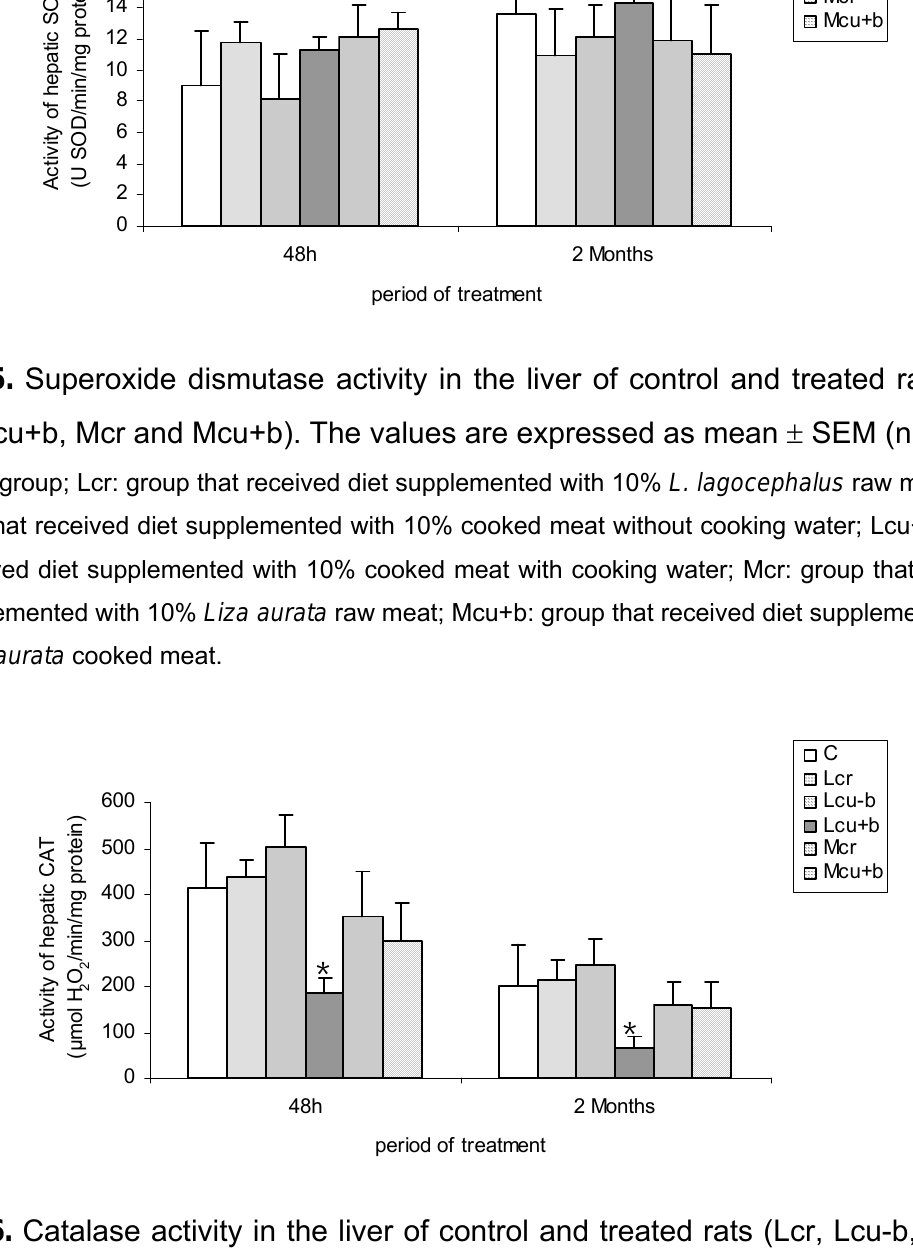
Figure 6. Catalase activity in the liver of control and treated rats (Lcr, Lcu-b, Lcu+b, Mcr and Mcu+b). The values are expressed as mean ± SEM (n = 6). Significant levels observed are * p ≤ 0.05 compared with control group